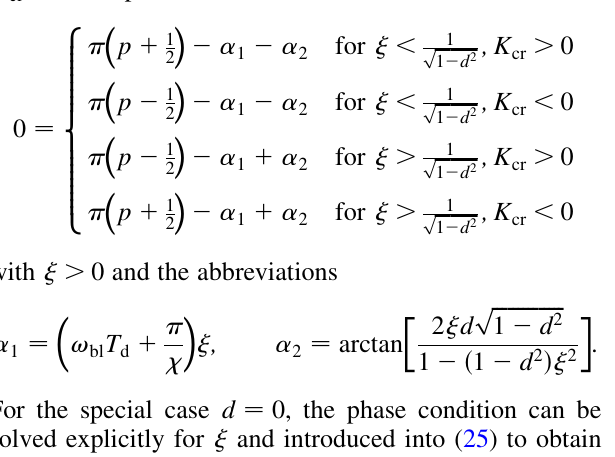
FIG. 8. Stability depending on the feedback gain K for d ¼ 0 (dark shading) and d ¼ 0 : 15 the filter frequency f pass (light shading). Settings of beam experiment run C ( (cid:4) ).